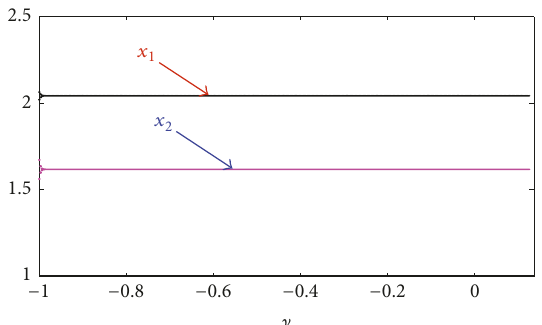
Figure 15: Bifurcation diagram of system (14) with 𝜇 ∈ [−1,0.1362] , for (𝛼 1 = 1.39, 𝛼 2 = 0.36)